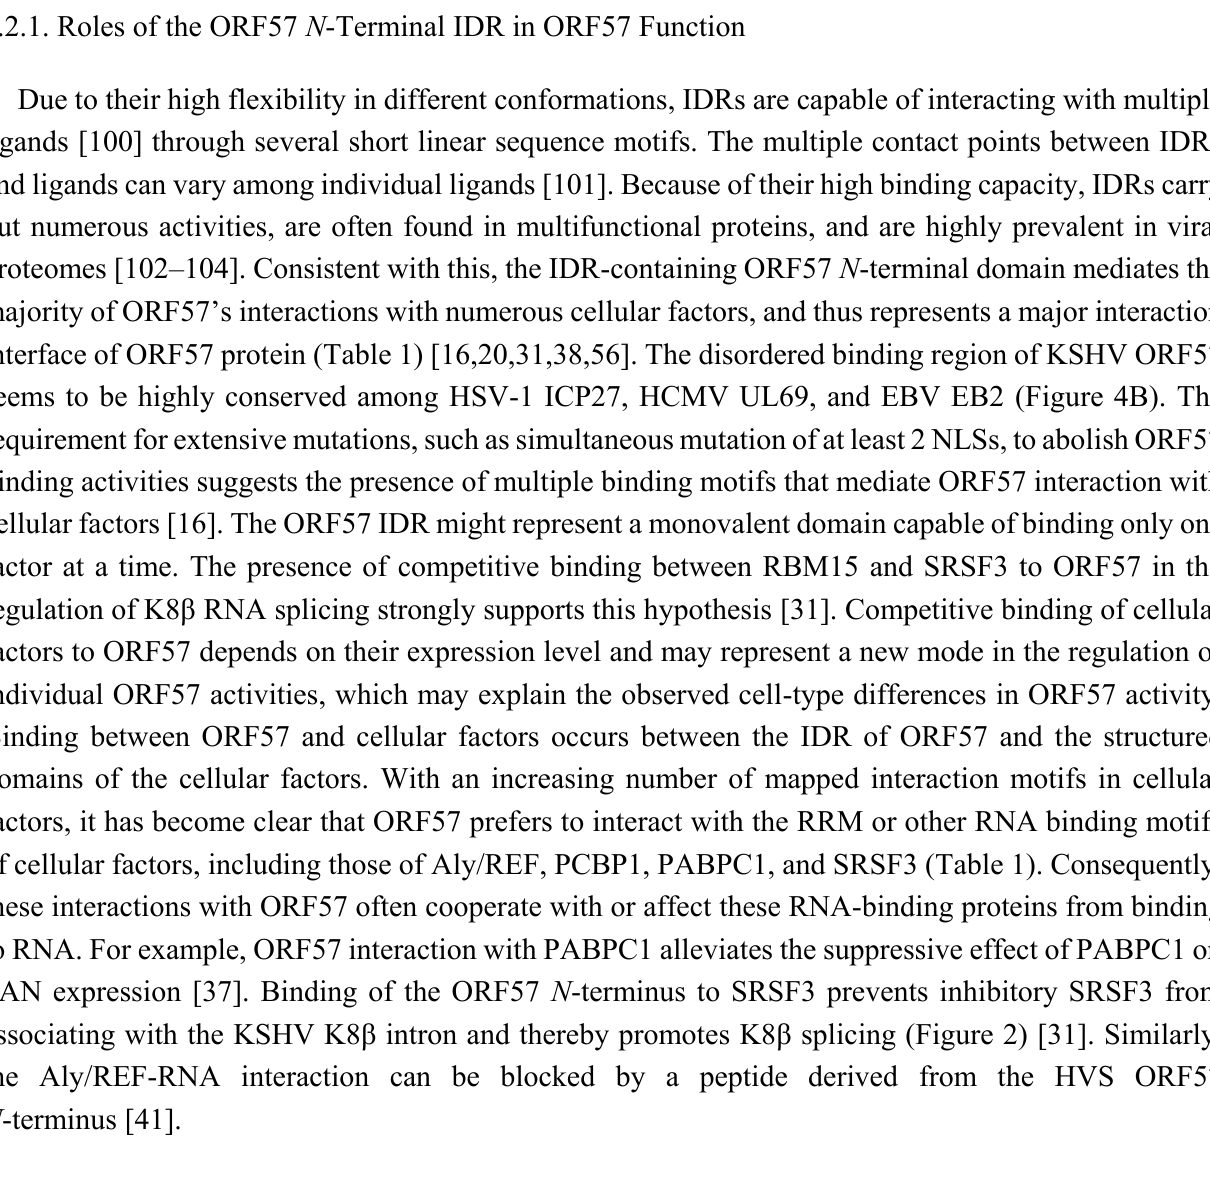
( C ) Phosphorylation sites predicted from KSHV ORF57, HSV-1 ICP27, HCMV UL69, and EBV EB2 proteins by DISPHOS 1.3 software for viruses group predictor, with a